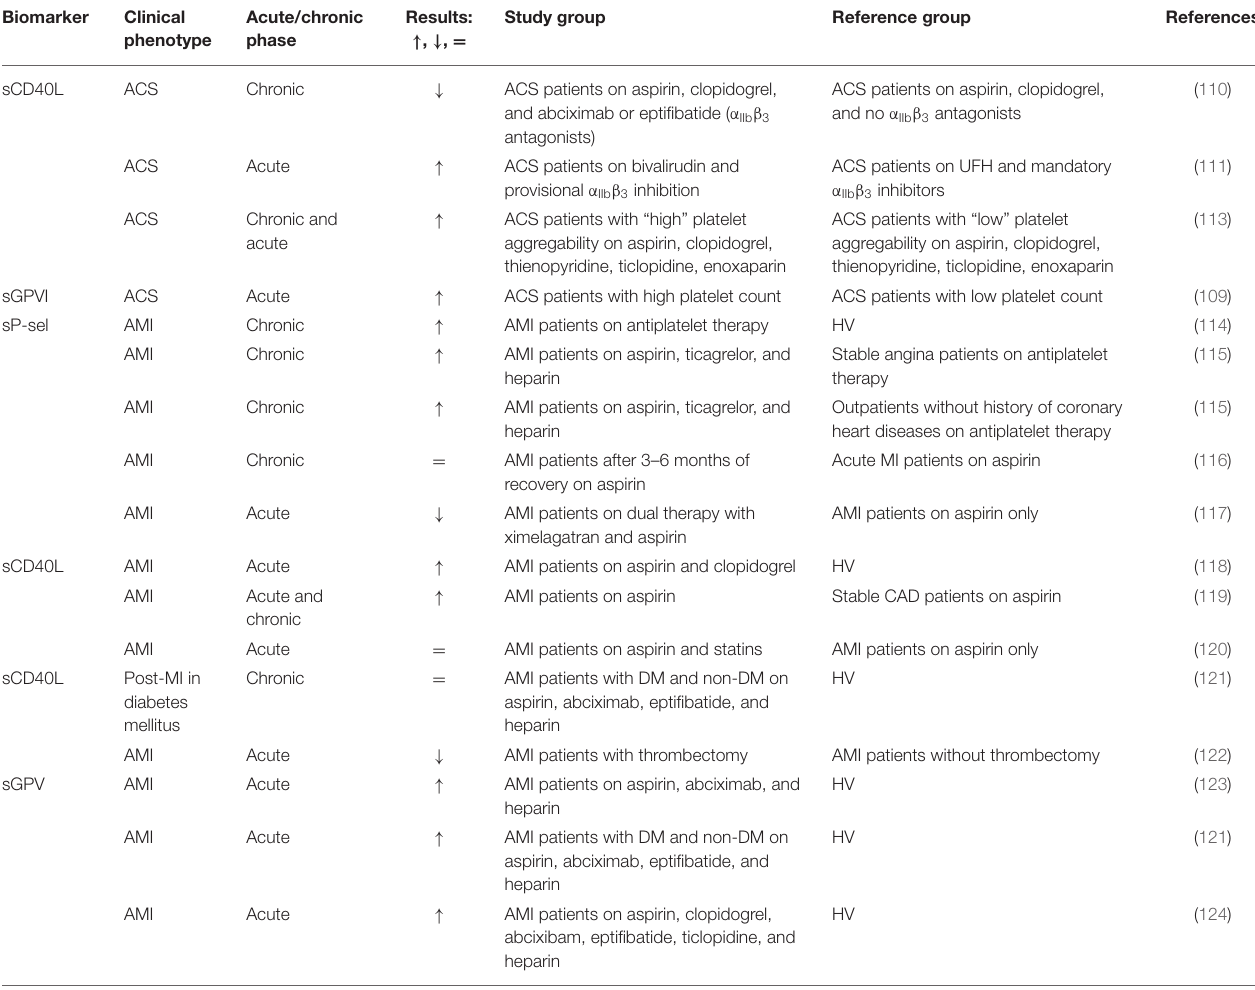
TABLE 3 | Soluble biomarkers of platelet activation in acute coronary syndrome (ACS) and acute myocardial infarction (AMI) patients.